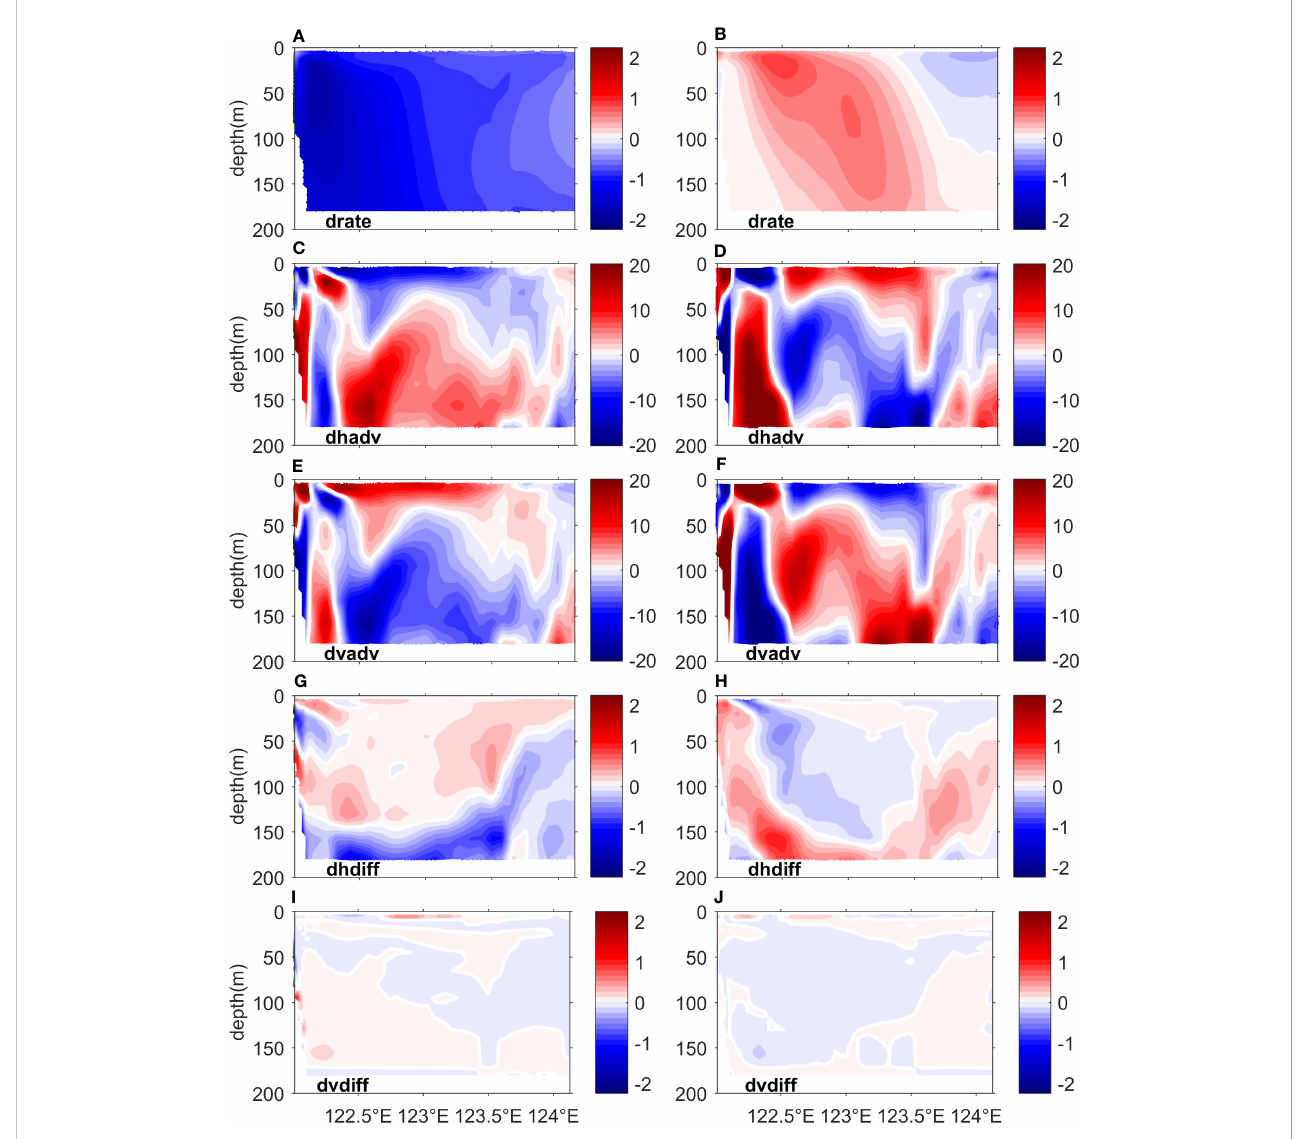
FIGURE 12 The variation in time-integrated contribution terms (10 -6 kg/m 3 /s) in the diffusion equation (3) along the 200 m isobaths from t=1 day to t=30 days under the effect of ( A, C, E, G and I ) cyclonic and ( B, D, F, H and J ) anticyclonic